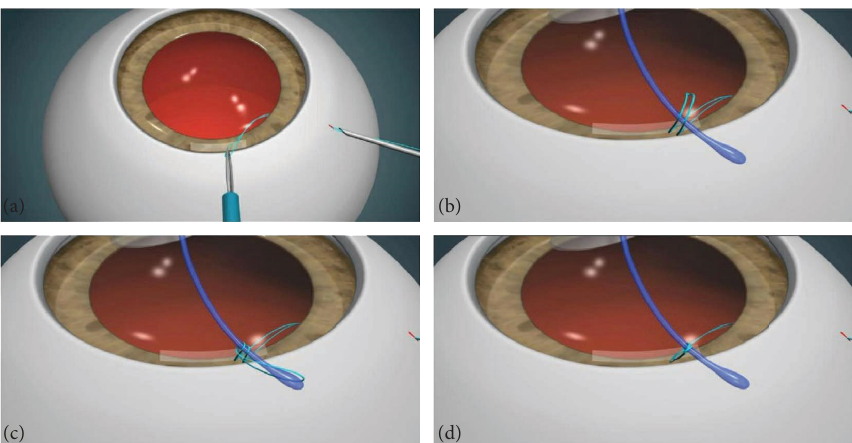
Figure 1: Schematic fgures of performing the modifed cow-hitch knot to fxate the intraocular lens (IOL): (a) the suture-in-needle technique was performed to introduce the suture into the eye from the fxation site, and the loop was externalized by forceps. (b) Te loop of suture was passed proximally towards the optic of the IOL, then behind the twirl, and moved distally to lasso the end of the haptic. (c) Te suture was looped around the end of the haptic. (d) Te modifed cow-hitch was fnally tightened.